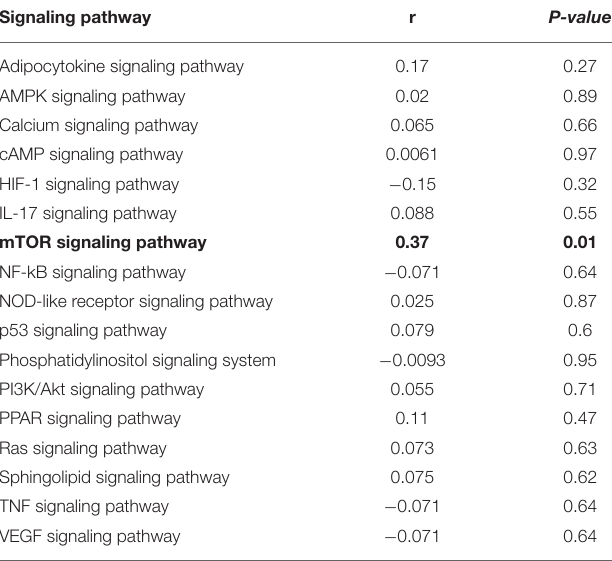
TABLE 2 | The correlation between the functional pathway of microbiome and the positive rate of M2 type TAM in HCC-MVI group based on the KEGG